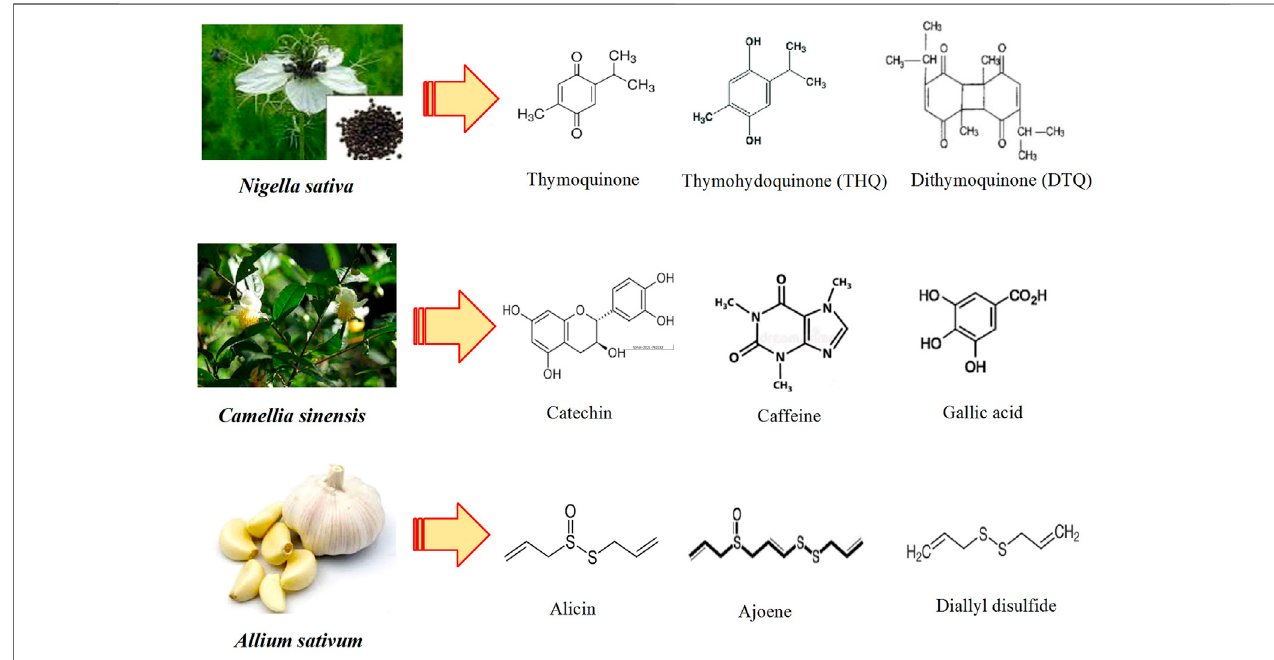
FIGURE 1 | Chemical structures of main bioactive compounds of medicinal herbs.